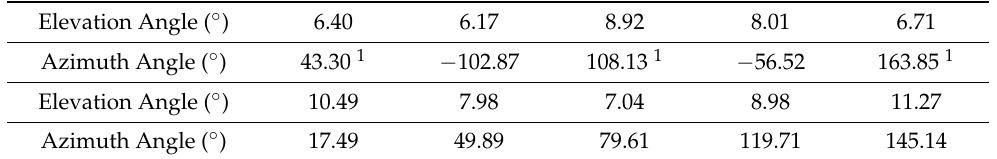
Table 9. DOA estimation of nearby outer race by UCMA-ESPRIT for rolling element fault signal at 290 rpm.